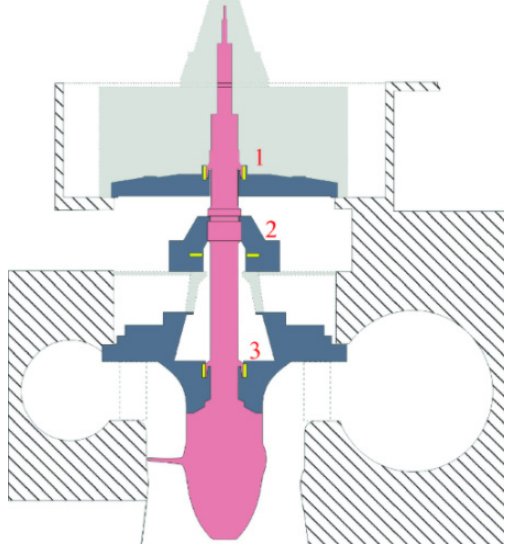
Figure 2. Bearing positional layout of the hydraulic unit [45]. (1). Thrust bearing. (2). Lower guide bearing. (3) Turbine guide bearing.